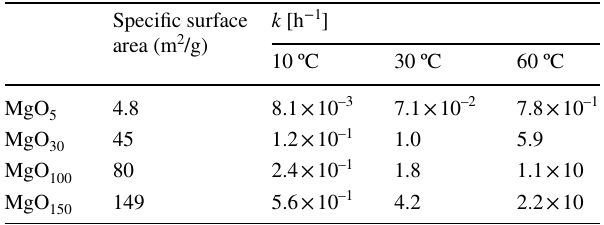
Fig. 4 Changes in fluorine concentration over time at 10, 30, and 60 ºC for a MgO5, b MgO30, c MgO100, and d MgO150 (Amount of MgO: Mg/F = 10)